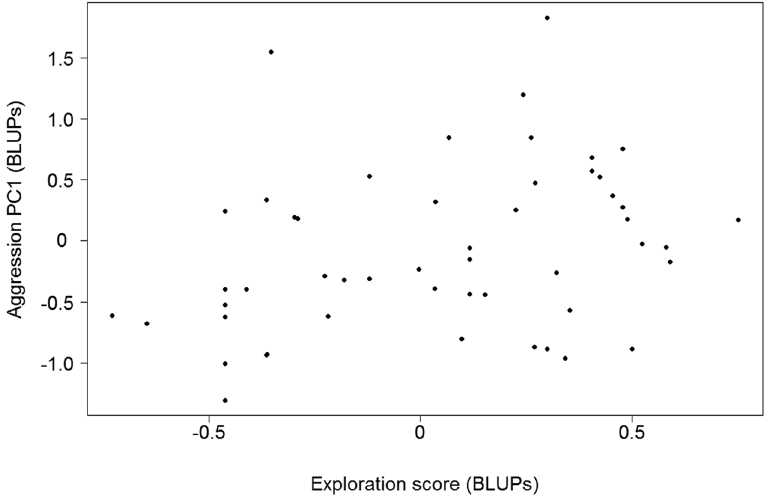
Figure 2. Plot of the relationship between aggressiveness (PC1) and exploration scores in female great tits (N = 51) on the individual level. To illustrate the individual-level relationship we plotted best linear unbiased predictors (BLUPs) from the minimum adequate model (MAM) for aggression PC1 (see Table 2) against the BLUPs of the MAM for female exploration scores (see Table 3). Real analysis was based on a univariate mixed model (see Statistical analyses) and more exploratory females were found to be more aggressive (regression coefficient β = 0.87 [0.08,